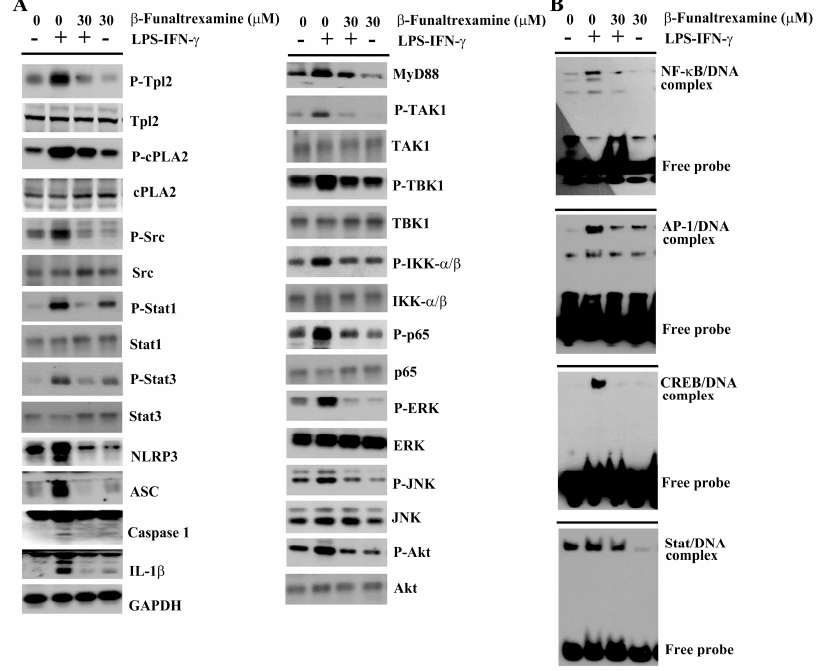
Figure 4. β -funaltrexamine alleviated intracellular signaling molecule activation. Neuron / glia cultures were pretreated with vehicle or β -funaltrexamine (30 µ M) for 30 min before being incubated with LPS (100 ng / mL) / IFN- γ (10 U / mL) for an additional 4 h. ( A ) Total cellular proteins were extracted and subjected to Western blot analysis with indicated antibodies. ( B ) Nuclear proteins were extracted and subjected to Electrophoretic Mobility Shift Assay (EMSA) for the measurement of NF- κ B, AP-1, cAMP-Response Element Binding Protein (CREB), and Stat DNA binding activities. One representative blot of four independent culture batches is shown.